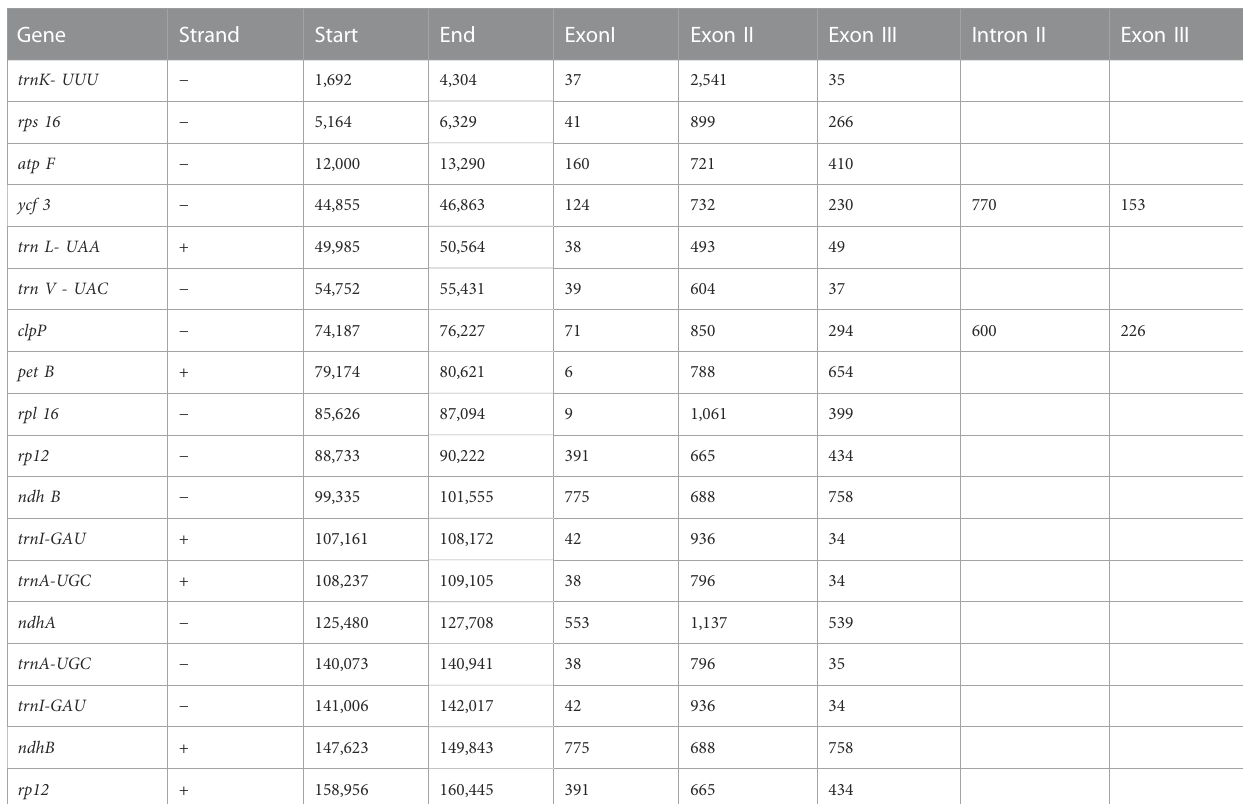
TABLE 2 The length of intragenic regions. Gene